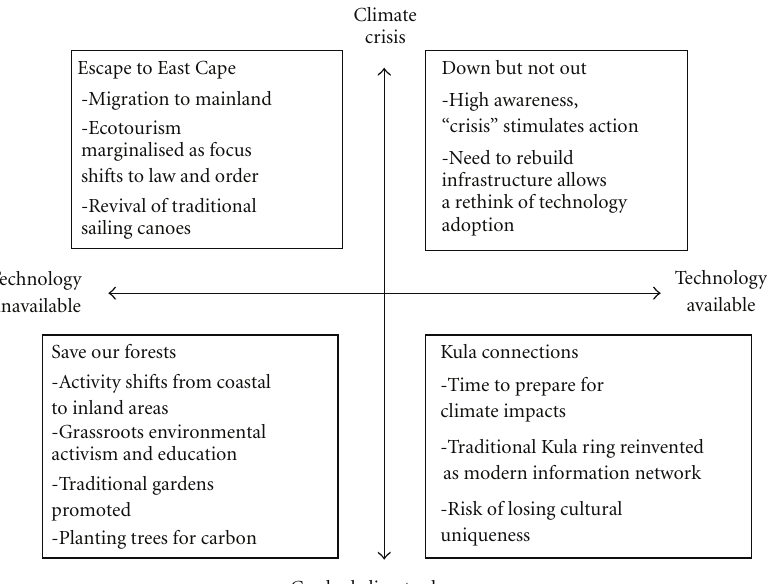
Figure 4: Four scenarios based on interactions of the most uncertain drivers identified by the stakeholder group: the speed and nature of climate change and the availability of low-cost, readily adoptable